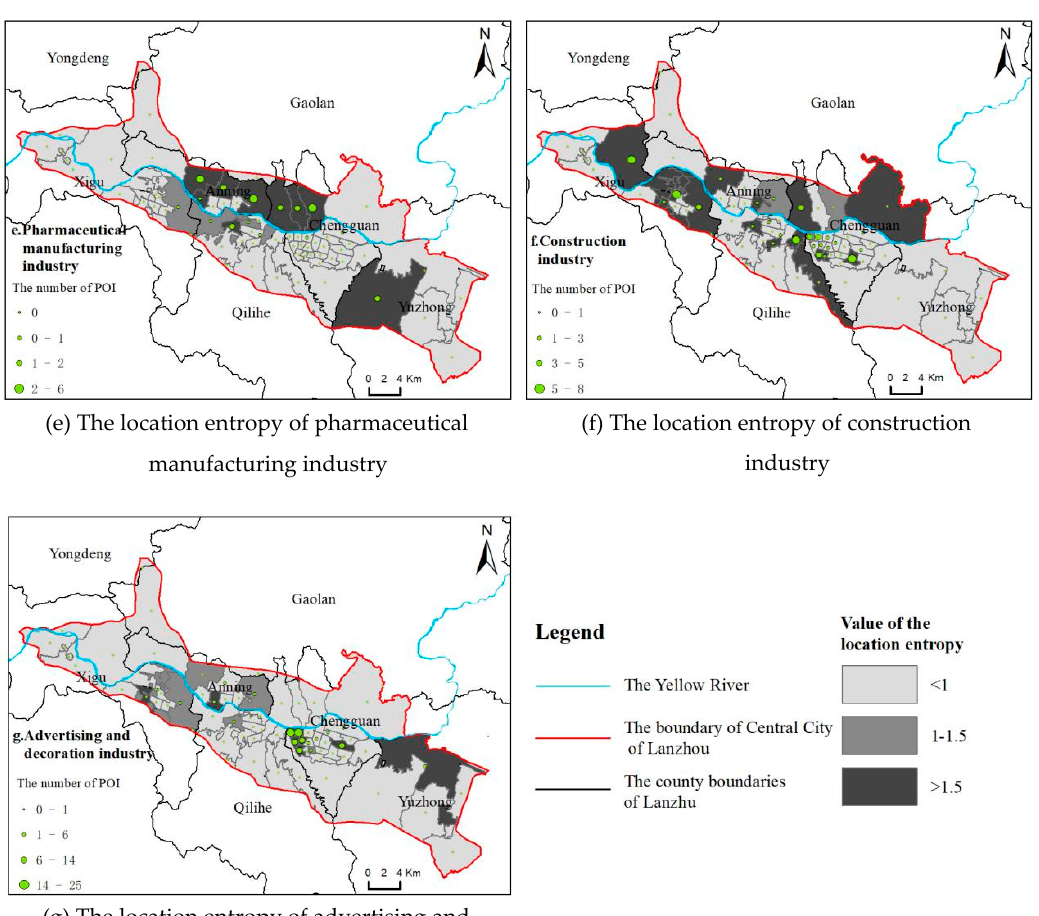
Figure 10. The distribution of location entropy in secondary industry.